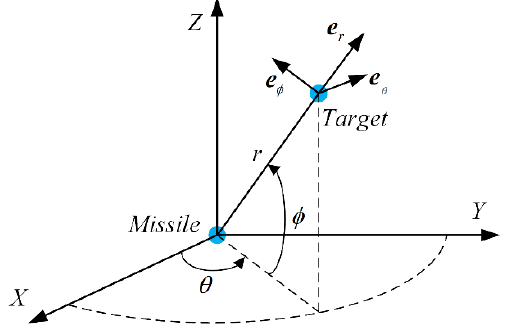
Figure 1. Three-dimension schematic diagram of missile-target engagement. The relative velocity in LOS coordinate system satisfies the following differential form